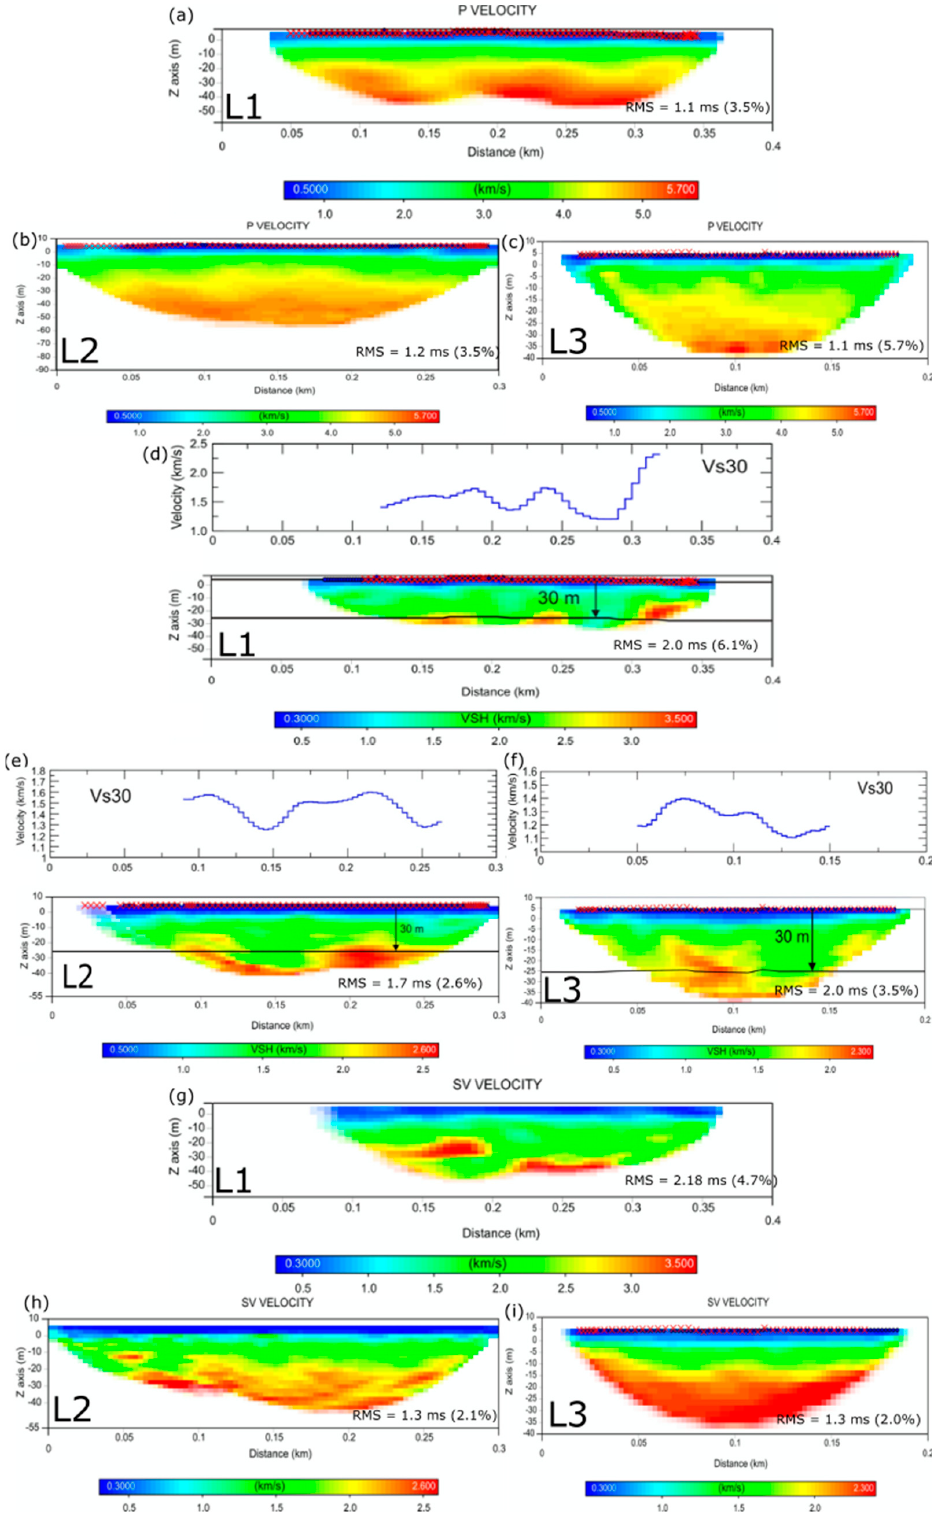
Figure 4. Results of the tomographies in Croatia; in the bottom-right corner, the value of the mean RMS error is shown. ( a ) Line 1, P-waves, ( b ) Line 2, P-waves, ( c ) Line 3, P-waves, ( d ) Line 1, SH-waves and V S30 , ( e ) Line 2 SH-waves and V S30 , ( f ) Line 3 SH-waves and VS30, ( g ) Line 1 SV-waves, ( h ) Line 2 SV-waves, ( i ) Line 3 SV-waves.